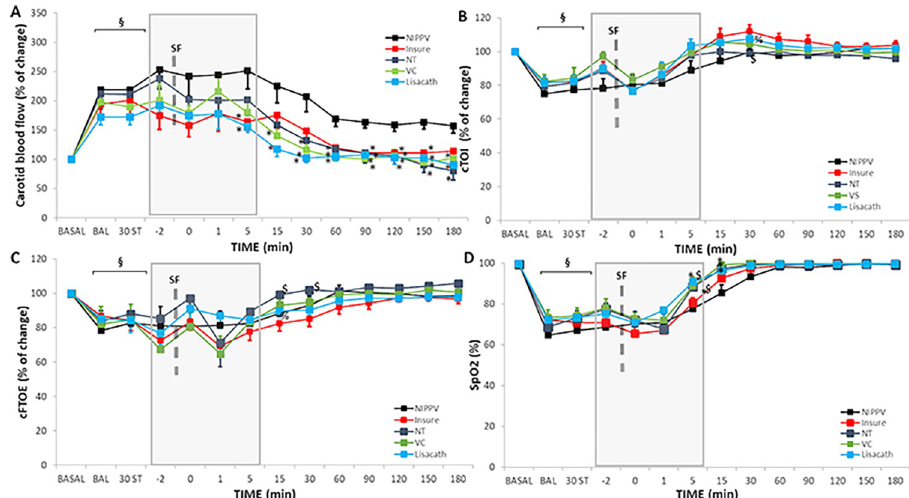
Fig 5. Carotid blood flow, cerebral tissue oxygenation index (cTOI), cerebral fractional tissue oxygen extraction (cFTOE) and pulse oximetry (S pO2 ) in newborn piglets with bronchoalveolar lavage-induced respiratory distress treated with nasal-intermittent-positive-pressure-ventilation (NIPPV) without SF therapy or with SF therapy, using the INSURE-like method, LISA with a nasogastric tube (NT), LISA with a vascular catheter (VC) or LISA with the LISAcath 1 catheter during the 180-min treatment period. Mean carotid blood flow (A), cTOI (B), cFTOE (C) and S pO2 (D) values in the NIPPV alone (black), INSURE (red), NT (dark-blue), VC (green) and LISAcath (blue) groups. The -2 time-point represents the 2min before SF administration and 0 time-point following completion of SF